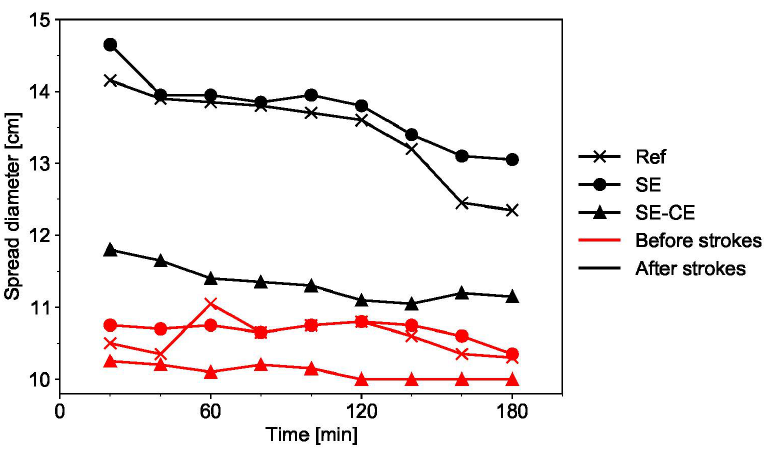
Figure 8. Spread diameter of printable SHCC mixtures over time.